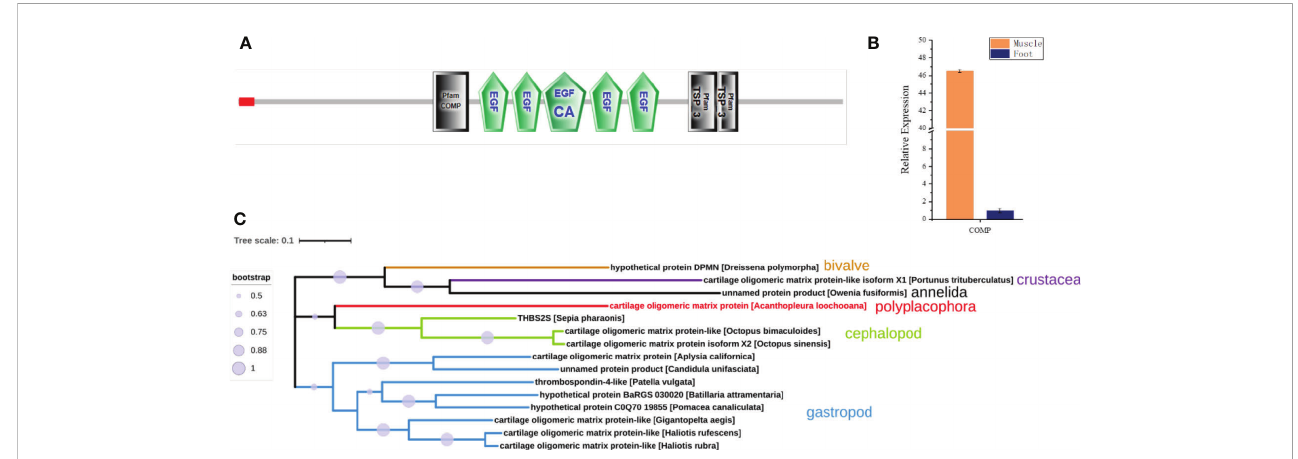
FIGURE 7 Cartilage oligomeric matrix protein (COMP) analysis. (A) The molecular architecture of COMP. EGF, Epidermal growth factor-like domain; EGF_CA, Calcium-binding EGF-like domain; TSP_3, type 3 thrombospondin. (B) The relative expression of COMP in the muscle compared to the foot by qPCR. (C) The phylogenetic tree of COMP in Mollusca, Crustacean, and Annelida.